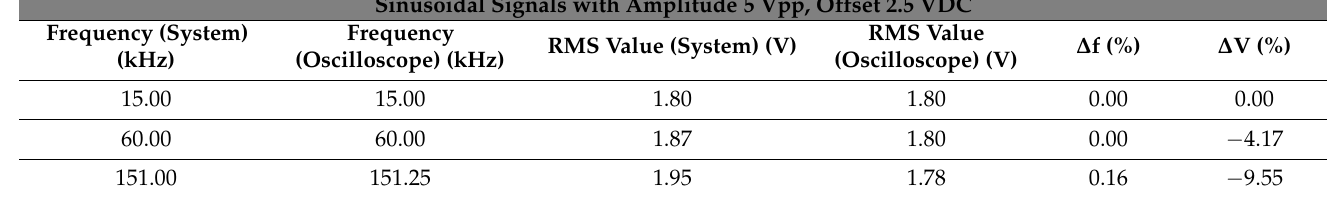
Table 2. Comparisons between the calibrated oscilloscope and the FPGA-based system measurements for sinusoidal signals with amplitude of 5 Vpp with 2.5 VDC offset value, for signal frequencies of 15 kHz, 60 kHz and 150 kHz.